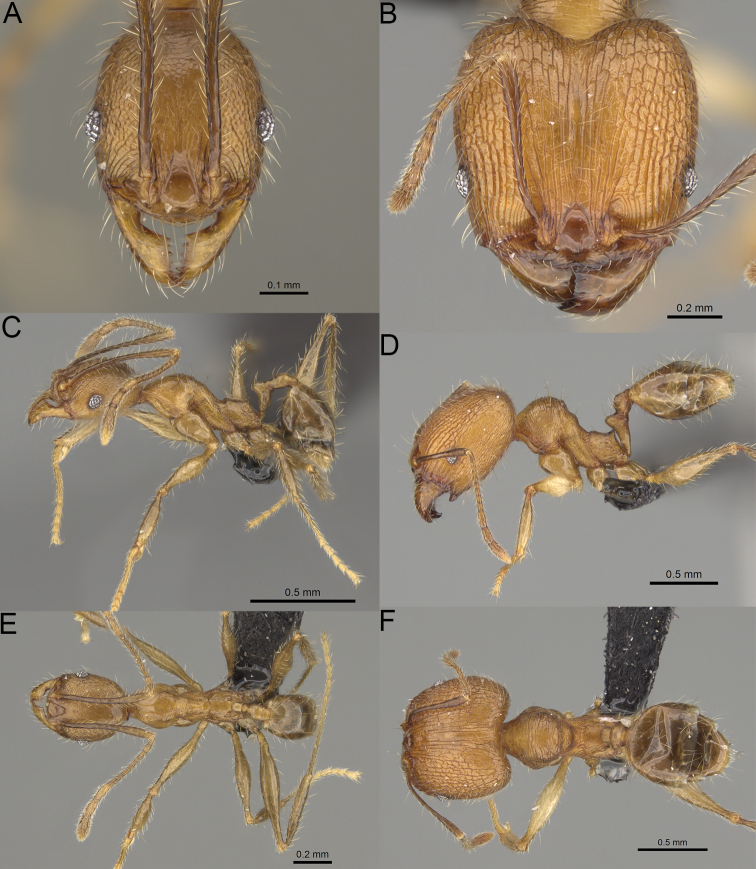
Pheidole
renirano sp. nov., full-face view (A), profile (C), and dorsal view (E) of paratype minor worker (CASENT0923324) and full-face view (B), profile (D), and dorsal view (F) of holotype major worker (CASENT0161924).